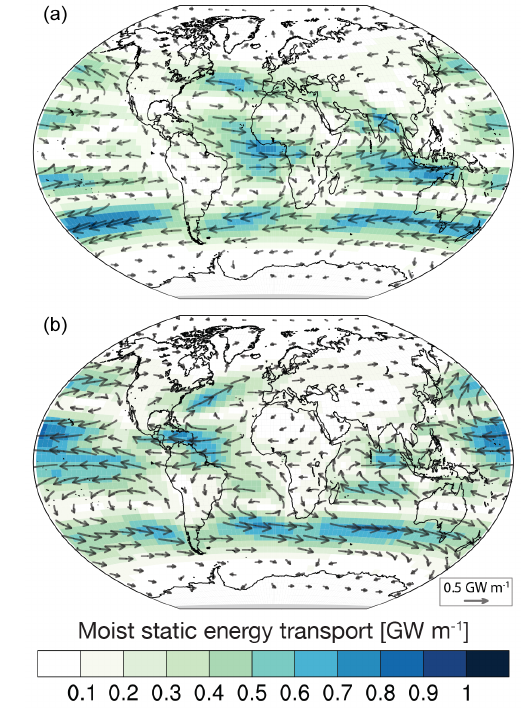
Figure 5. Moist static energy transport for RETRO (a) and CN- TRL (b) . To calculate the transport, we use 2-hourly data of veloc- ities, surface pressure, temperature, and specific humidity (Keith, 1995). The data are averaged over the last 100 years of the simula- tion.